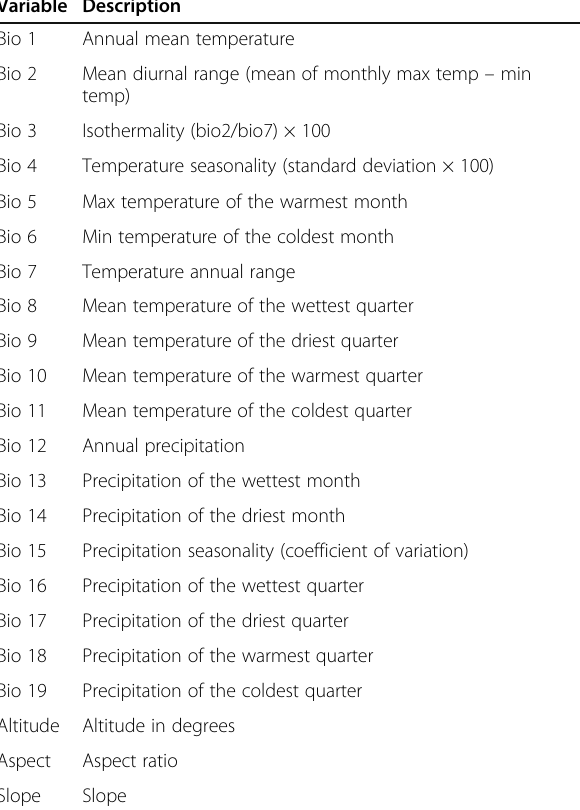
Table 1 Environmental and topographical variables used in Maxent to predict the current habitat suitability distribution of